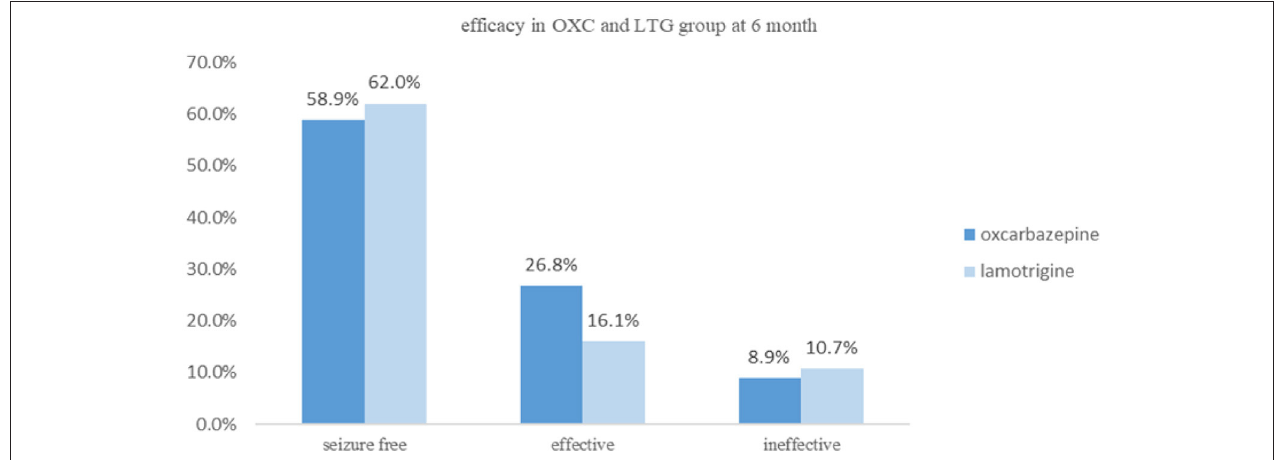
FIGURE 2 | Comparison of efficacy between OXC and LTG at 6 months follow-up.